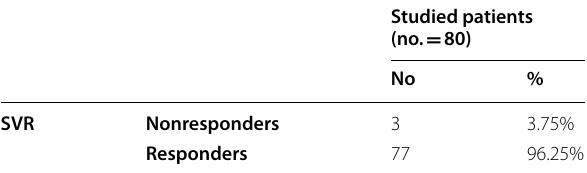
Fifty-six (70%) patients were treated by SOF/DAC regimen, while 24 (30%) patients were treated by SOF/DAC/RBV regimen